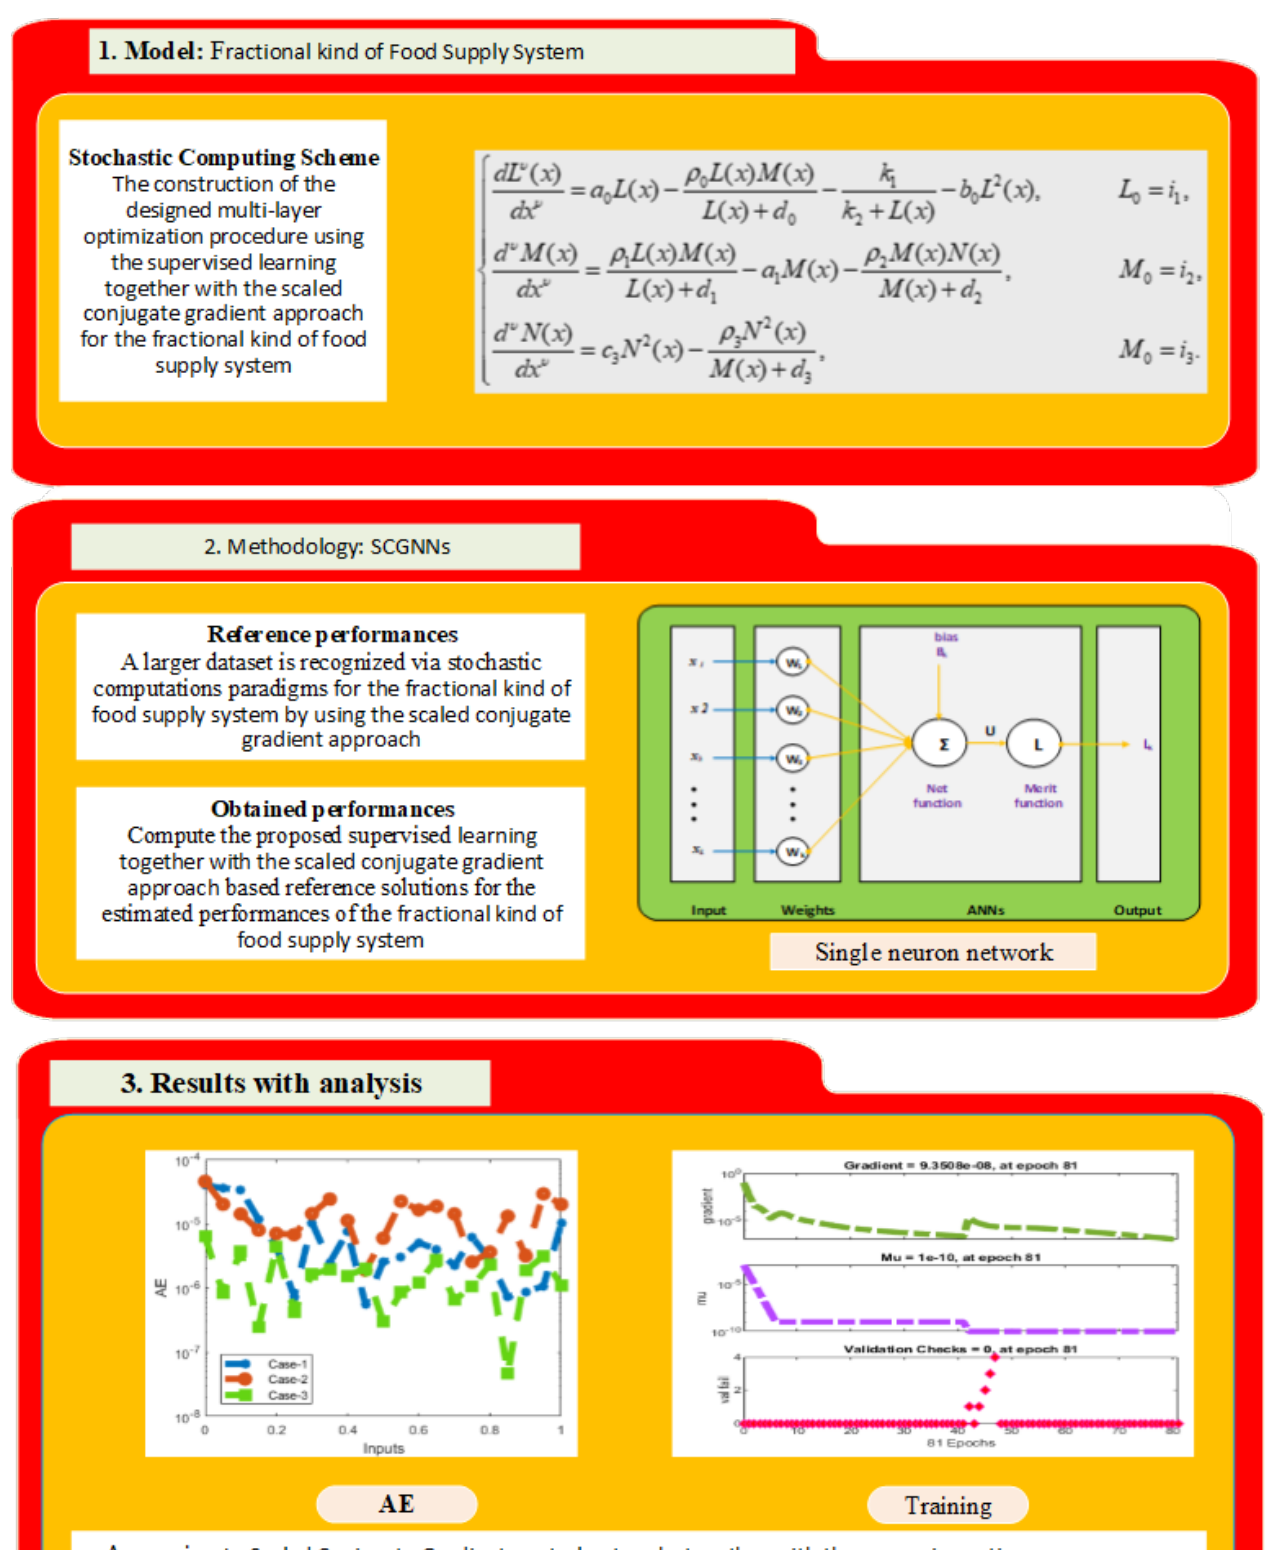
Figure 1. Workflow of the SCGNNs construction to solve the FKFS